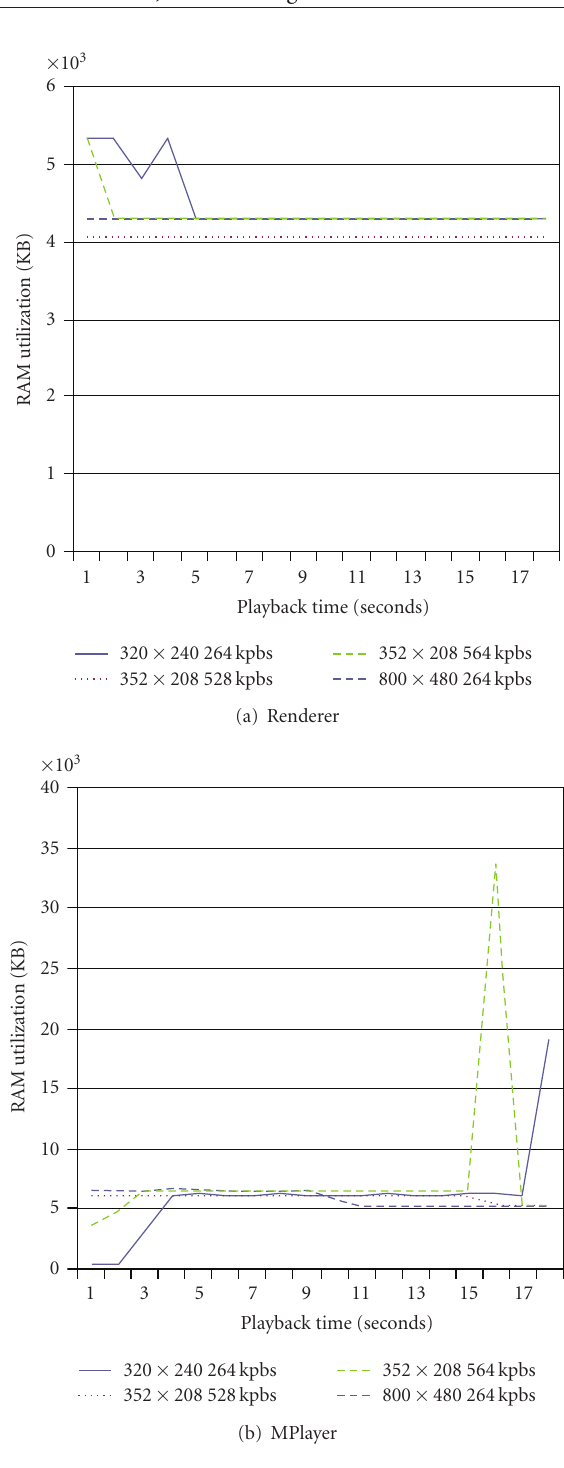
Figure 9: RAM utilization on the Nokia N770.